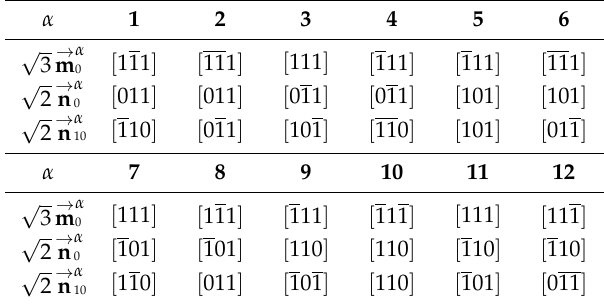
Table A1. List of slip systems for a BCC crystallographic structure